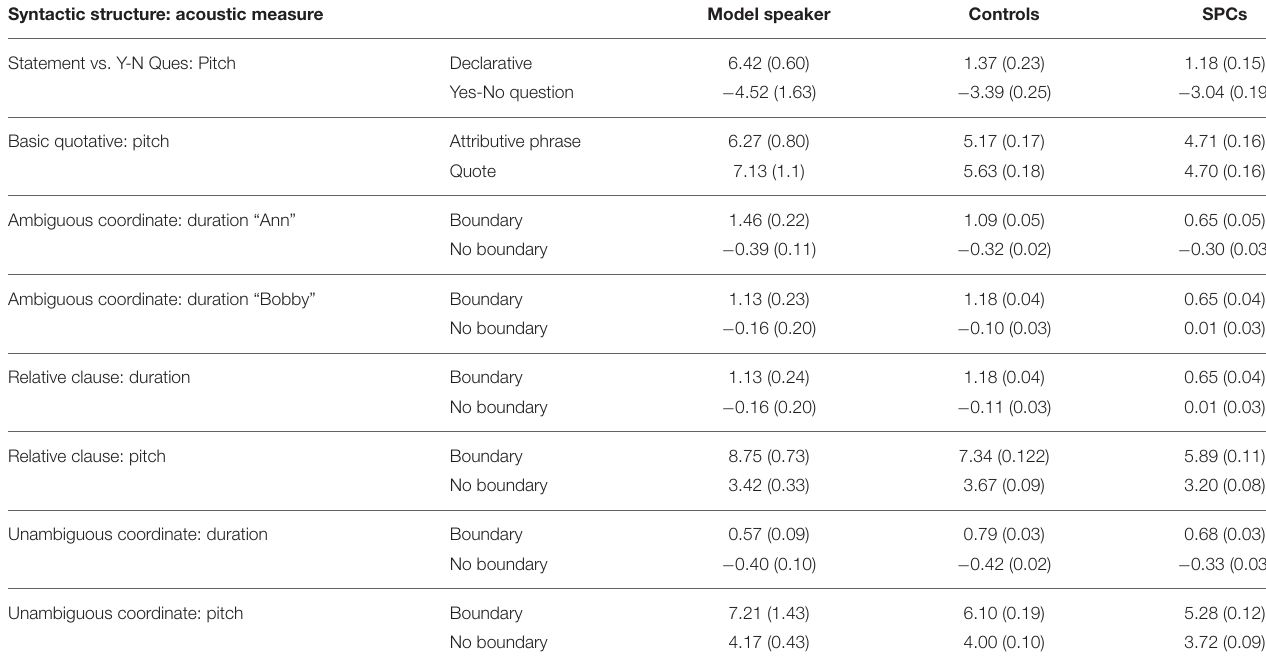
TABLE 3 | Means (and standard errors) of the acoustic measure of interest for each sentence type. Syntactic structure: acoustic